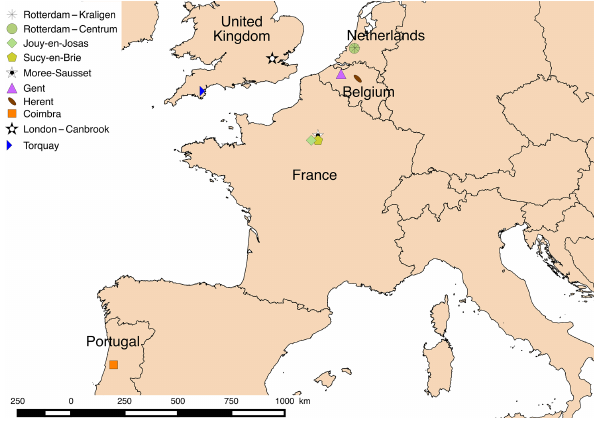
Figure 1. Location of the pilot urban